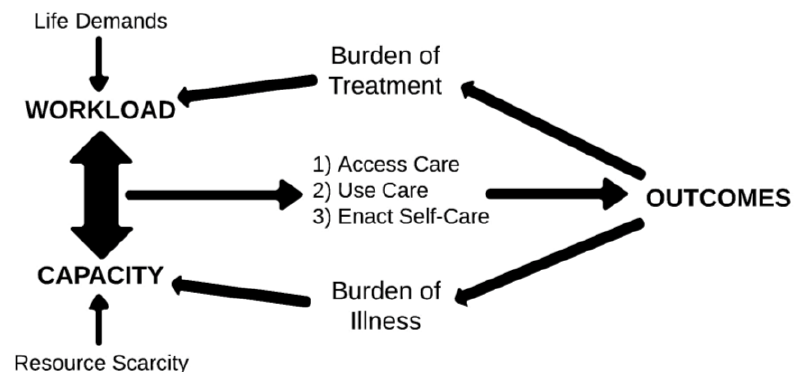
Figure 1. The cumulative complexity